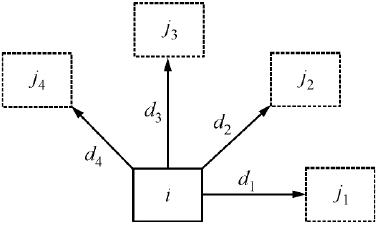
Figure 3. Gray-level co-occurrence matrix generation directions.